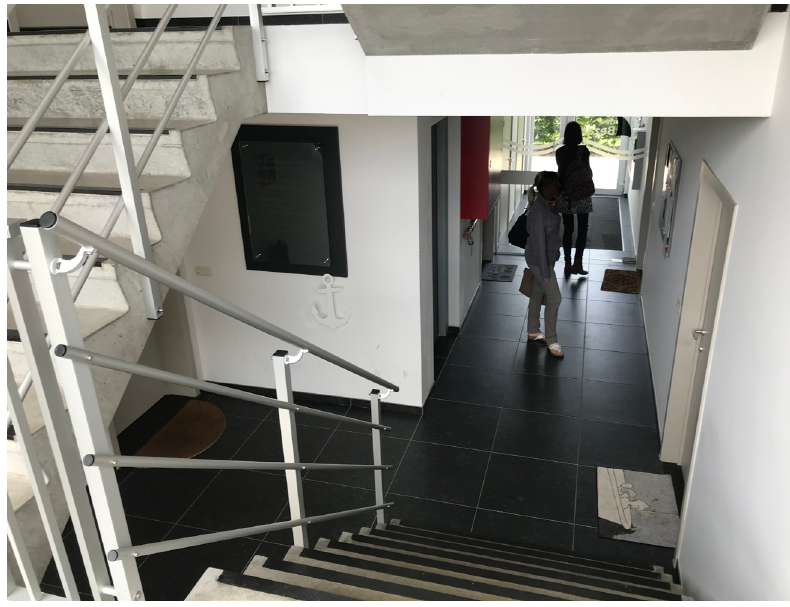
The entrance of the building, where Steve lives, is filled with natural doing a lot of stuff together and with his brother. But I don’t see much people (interview Leo).